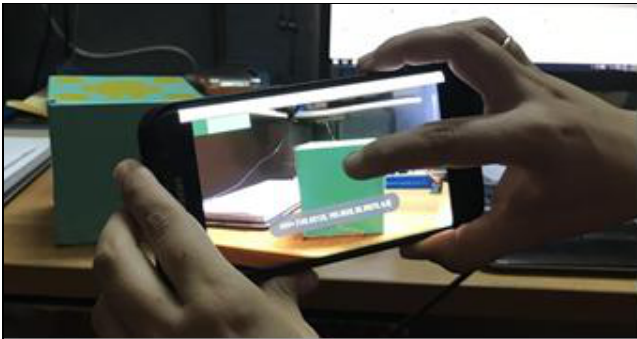
Figura 9: Usuario realizando la inserción del objeto a reconocer en el sistema.